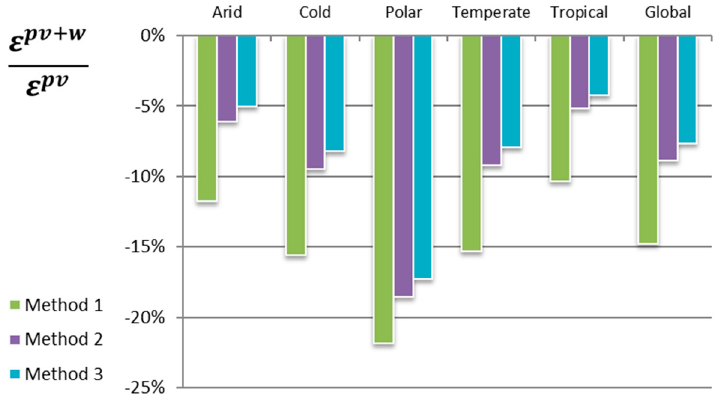
Figure 12. Improvement of the matching factor: ε pv+w (hybrid) over ε pv (solar PV) facilities.